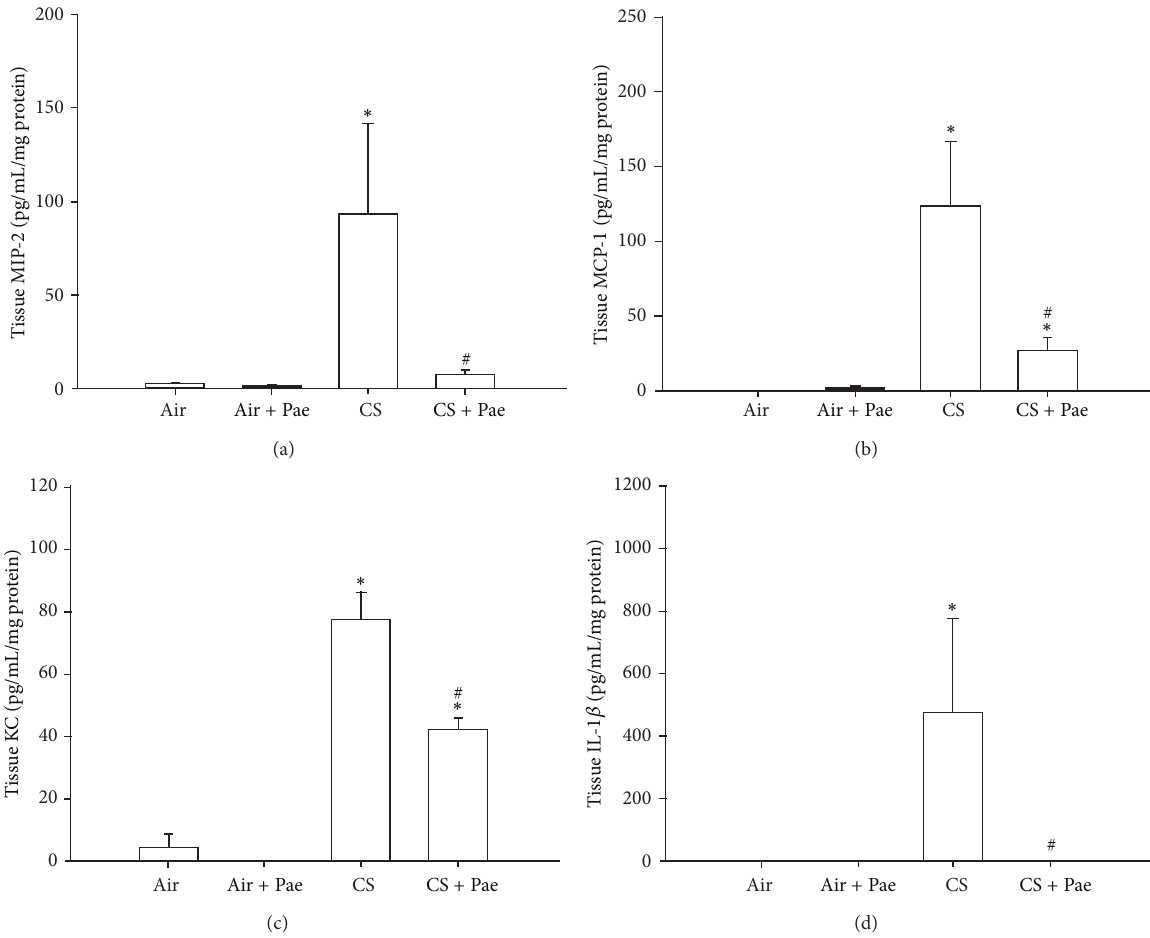
Figure 3: Paeonol (Pae) suppresses cigarette smoke- (CS-) induced increases in proinflammatory chemokines and cytokines in lung tissues sampled from mice. Levels of macrophage inflammatory protein 2 (MIP-2; (a)), monocyte chemoattractant protein-1 (MCP-1; (b)), keratinocyte chemoattractant (KC; (c)), and interleukin-1 𝛽 (IL-1 𝛽 ; (d)) in lung tissues were analyzed by ELISA. Data in each group are mean ± SEM from 7 mice. ∗ 𝑃 < 0.05 versus the air-exposure group; # 𝑃 < 0.05 versus the CS-exposure group with vehicle treatment. See legend of Figure 1 for detailed information on each study